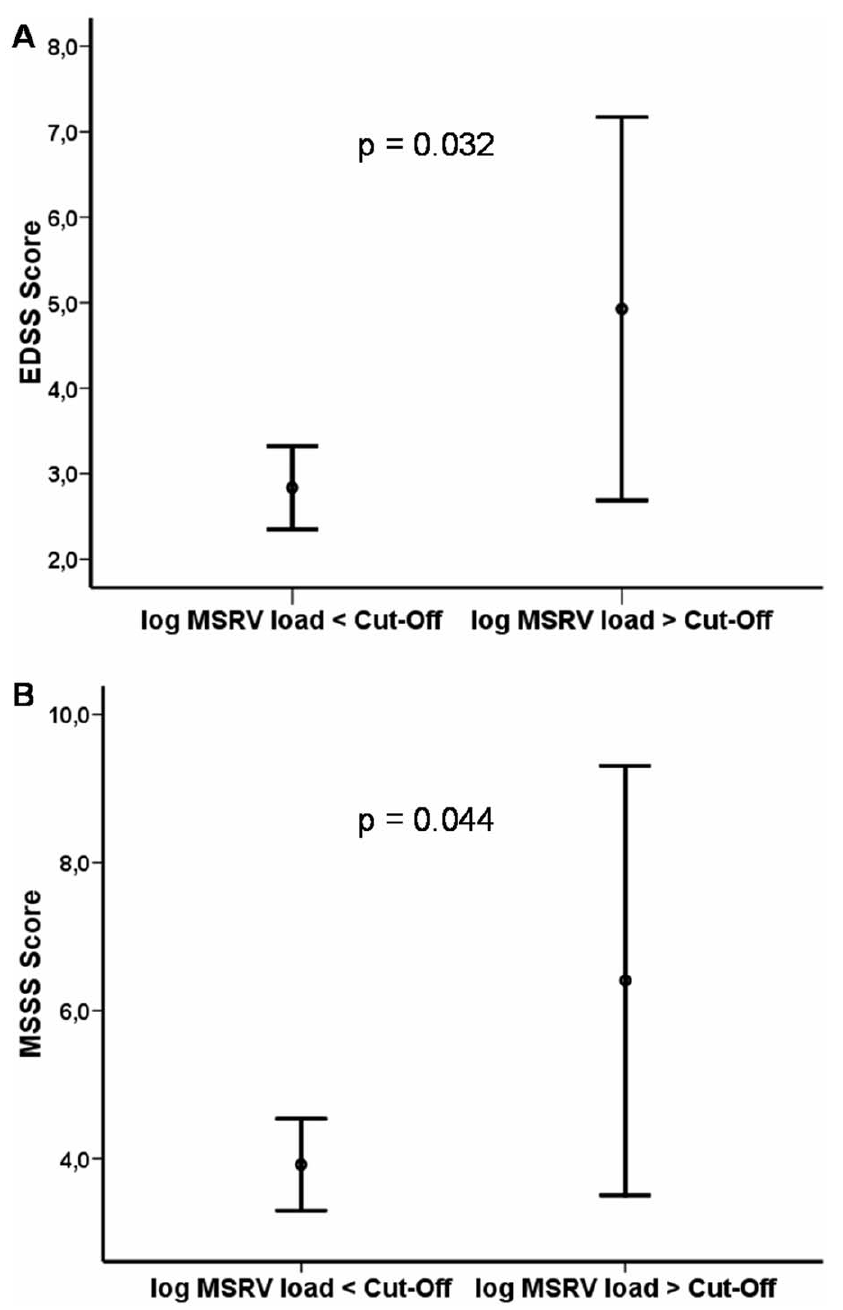
Figure 2. MSRV load and clinical evolution in women with MS. A) The EDSS Score is higher among patients with a MSRV DNA load above the Cut-Off* (Cut-Off=2.22, corresponding to 165 copies/pg of DNA) (n=7) than below (n=101). ANOVA; p=0.032. B) MSSS score is higher among patients with a MSRV DNA load above the Cut-Off*(n=7) than below (n=99). ANOVA; p=0.044. Points represent the mean and bars represent 95% Confidence Interval of Mean. MSRV load represents MSRV copies/pg of DNA. *Cut-Off=Mean log10 MSRV DNA Controls + 2*S.D log10 MSRV DNA Controls; This represents the threshold above which the values are no longer within the range of the normal population. doi:10.1371/journal.pone.0053623.g002 (Figure 2B) scores in women were higher among patients with a MSRV load above the Cut-Off of normal population (Cut- Off = 2.22, corresponding to 165 copies/pg of DNA; EDSS= 4.92 [2.68–7.16]; Mean MSSS= 6.40 [3.50–9.30] than among patients with a load below this normal threshold (Mean EDSS= 2.83 [2.35–3.32]; Mean MSSS = 3.92 [3.29–4.54]; ANOVA; p= 0.032 and p= 0.044, respectively).